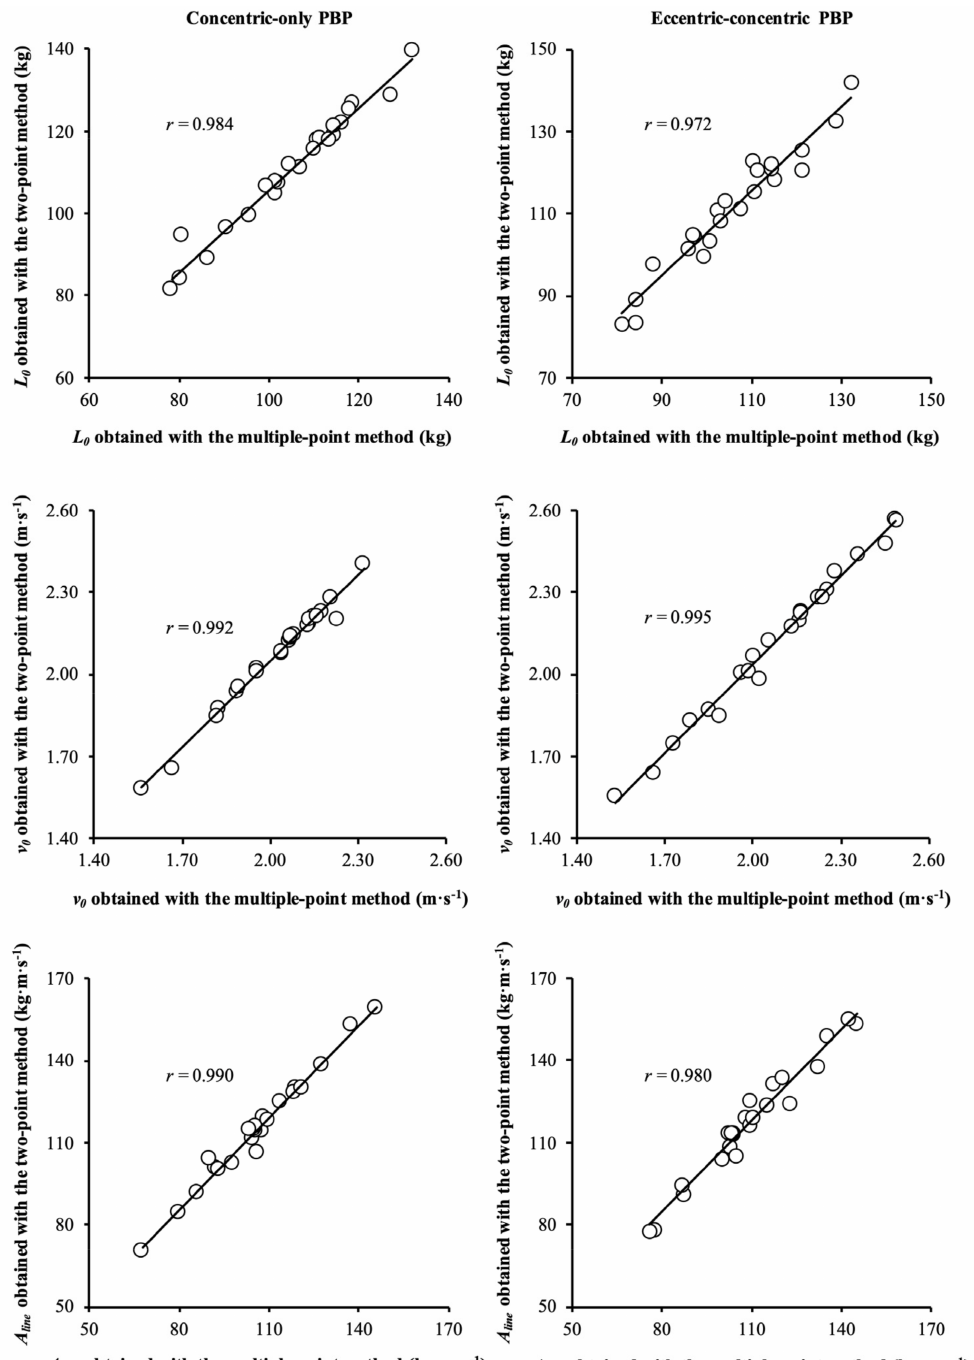
Figure 2. Correlations between the load–velocity relationship variables obtained with the multiple- point and two-point methods during the concentric-only (left panels) and eccentric–concentric (right panels) prone bench pull (PBP) variants. L 0 , load–axis intercept; v 0 , velocity–axis intercept; A line , area under the load–velocity relationship line; r , Pearson’s product-moment correlation